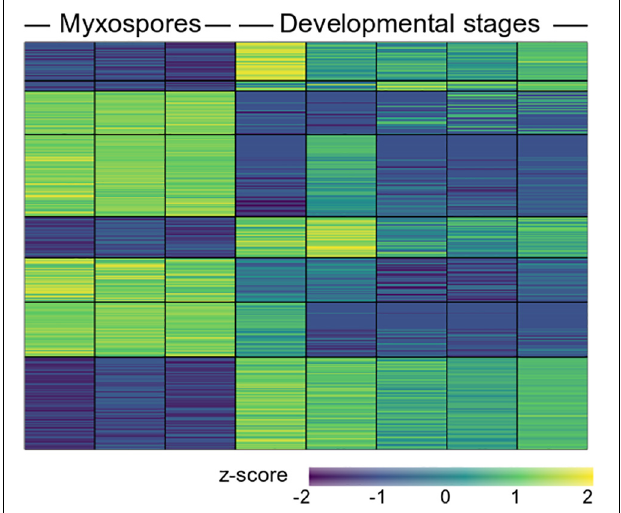
FIGURE 3 | Heat map showing 357 differentially expressed proteins (FDR adjusted P < 0.05) between mature myxospores and developmental stages ( n = 3 and n = 5 biological replicates, respectively). The full protein details are in Supplementary Table 3